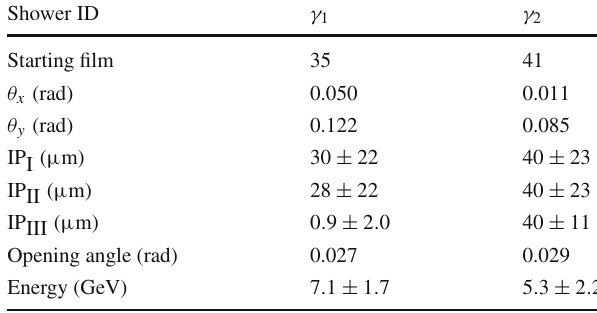
Table 3 Electromagnetic showers features. Reconstructed energies were estimated from the shower track multiplicity